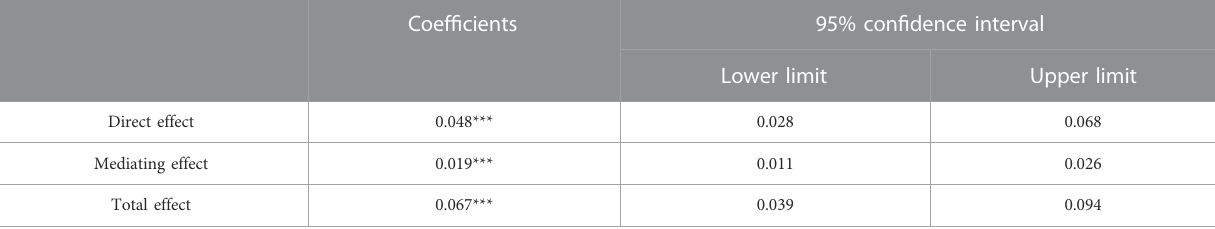
TABLE 11 Robustness tests for mediating effect model.